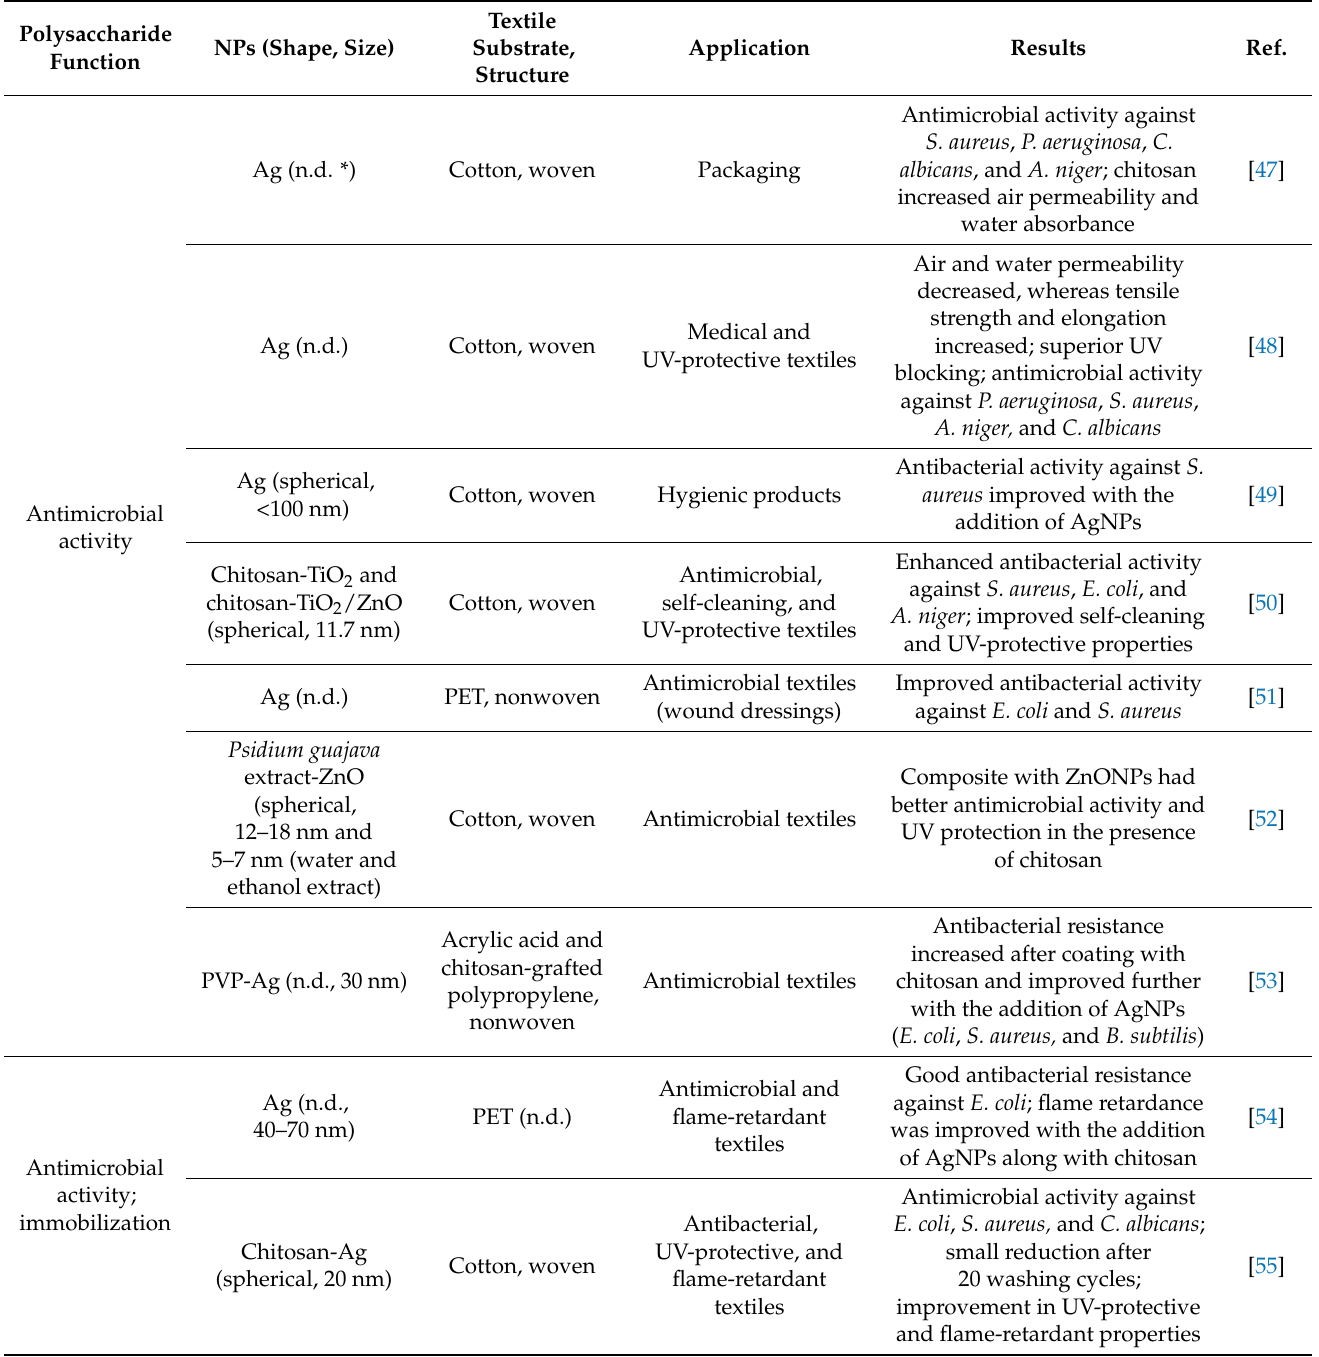
Table 1. Textile materials functionalized with chitosan and metal nanoparticles. Polysaccharide function towards